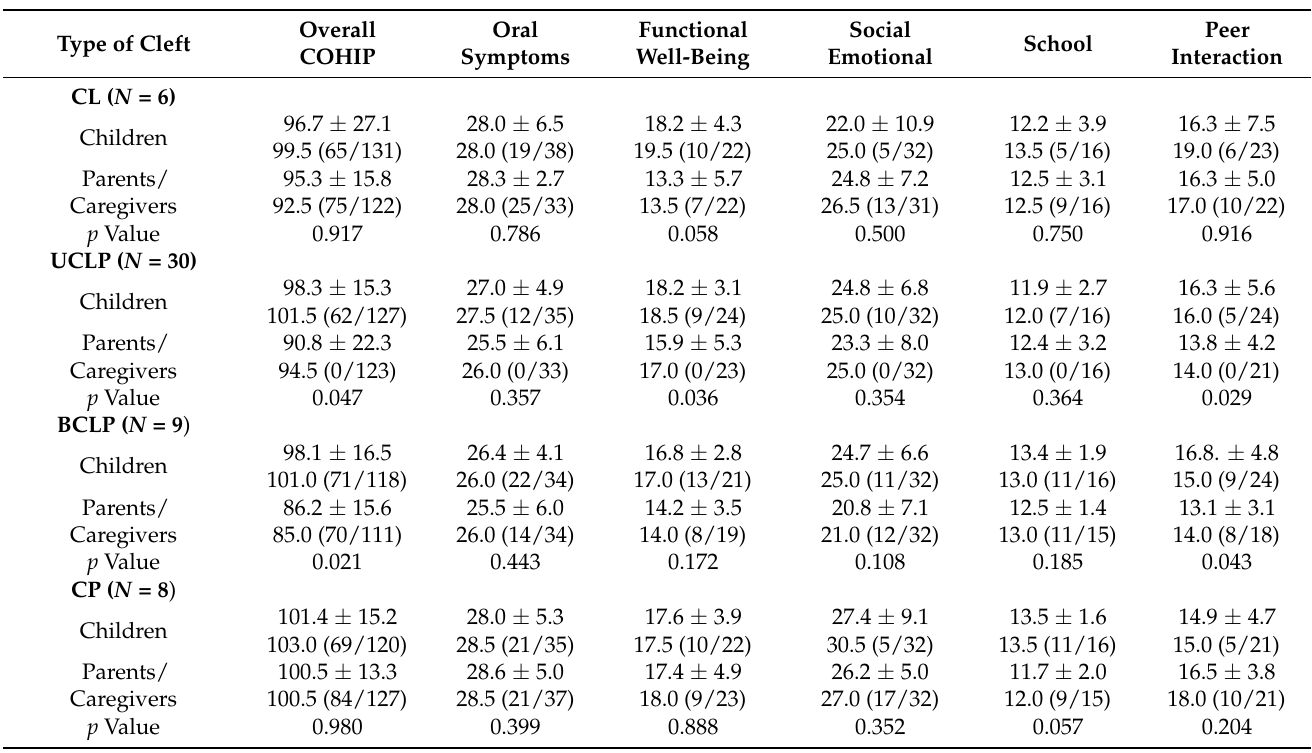
Table 7. Effect of cleft type on the agreement in COHIP overall and subscale scores between parents and children [mean ± SD, median,